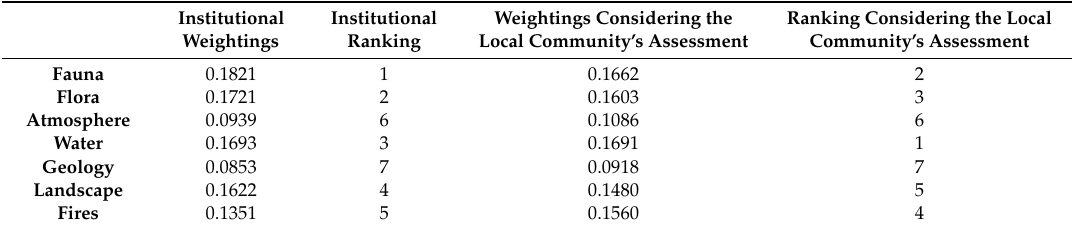
Table 3. Weightings and institutional ranking; weightings and ranking considering the local community’s assessments of the conservation objectives.